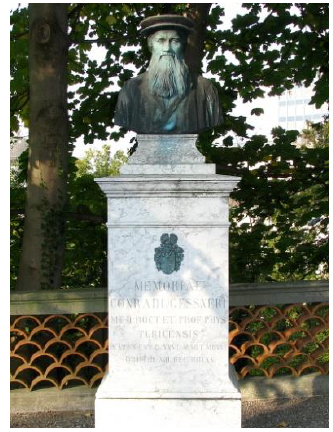
Figure 6. Konrad Gesner breast in Zurich Botanical Garden